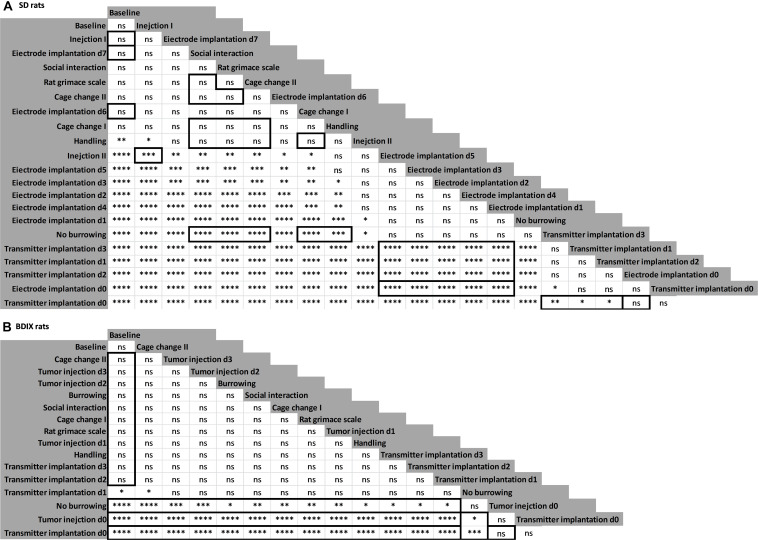
Statistical comparison of severity fractions of procedures. The fractions of data allocated to class high HR/low Act were statistically compared using a Fisher’s exact test; for SD rats (A) and BDIX rats (B); framed fields that are described in the section “Results”; *P < 0.05, **P < 0.01, and ***P < 0.001.